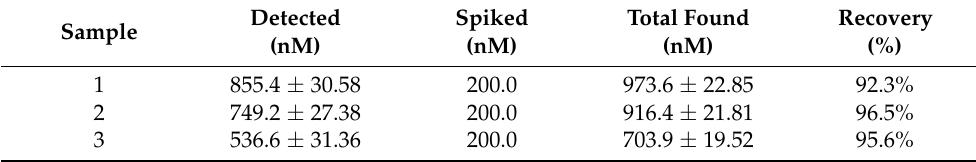
Table 2. Determination of H 2 S in joint fluid using the proposed sensor (n =